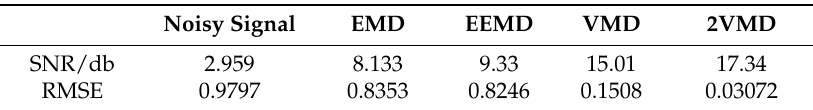
Table 4. The signal-to-noise ratio (SNR) and root mean square error (RMSE) for EMD, EEMD, VMD and 2VMD denoising.